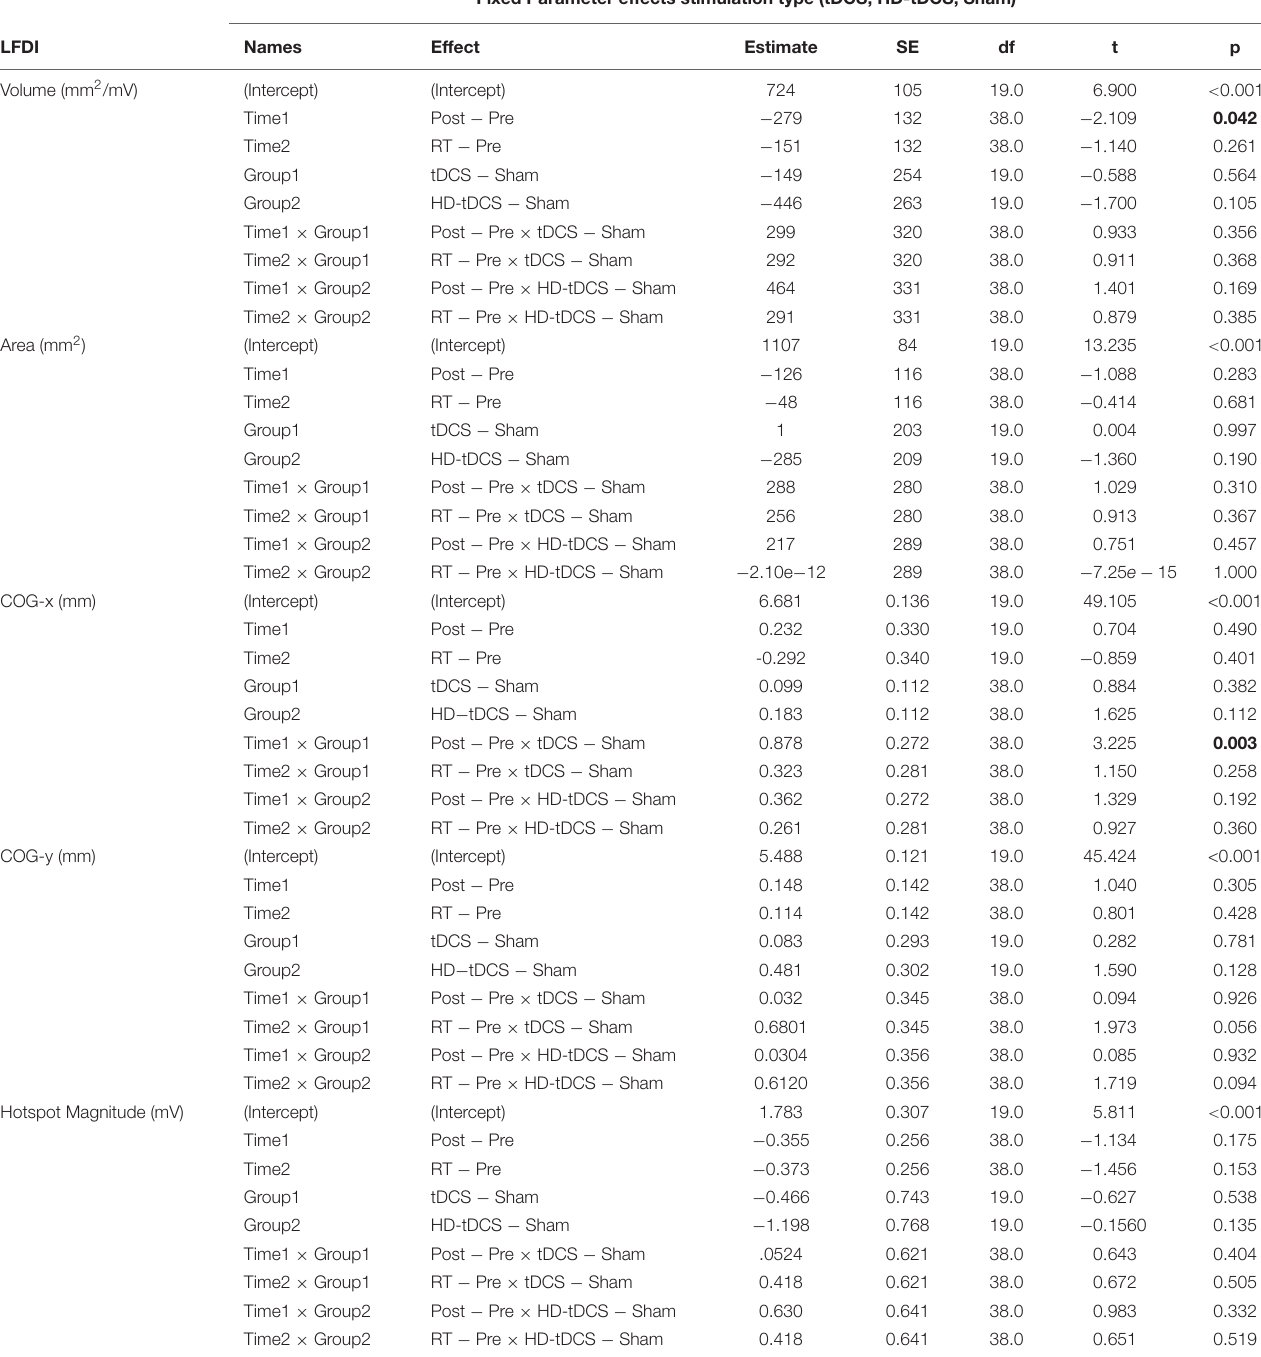
TABLE 4 | LFDI fixed parameters for motor map outcomes across intervention groups (stimulation type). Fixed Parameter effects stimulation type (tDCS, HD-tDCS,